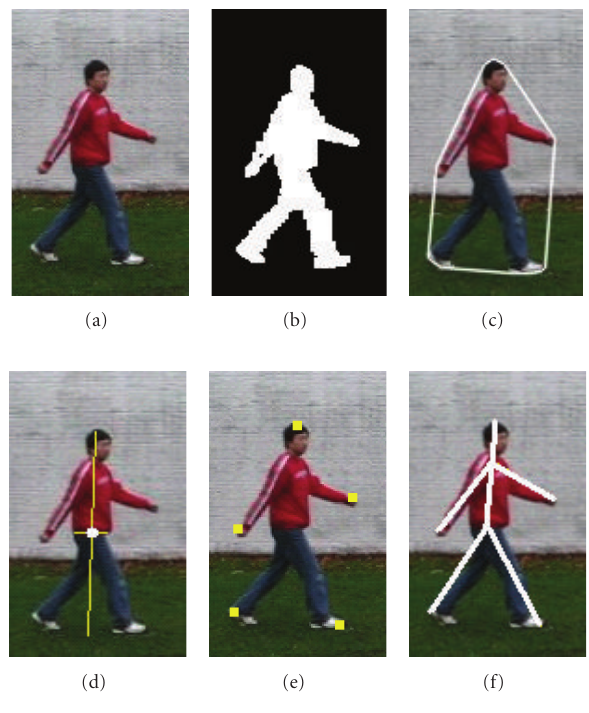
Figure 2: Procedure of skeleton-fitting processing: (a) original frame, (b) foreground segmentation (after shadow removal), (c) body modeling based on convex hull, (d) center-point estimation, (e) body-part location and, (f) skeleton construction in single- person